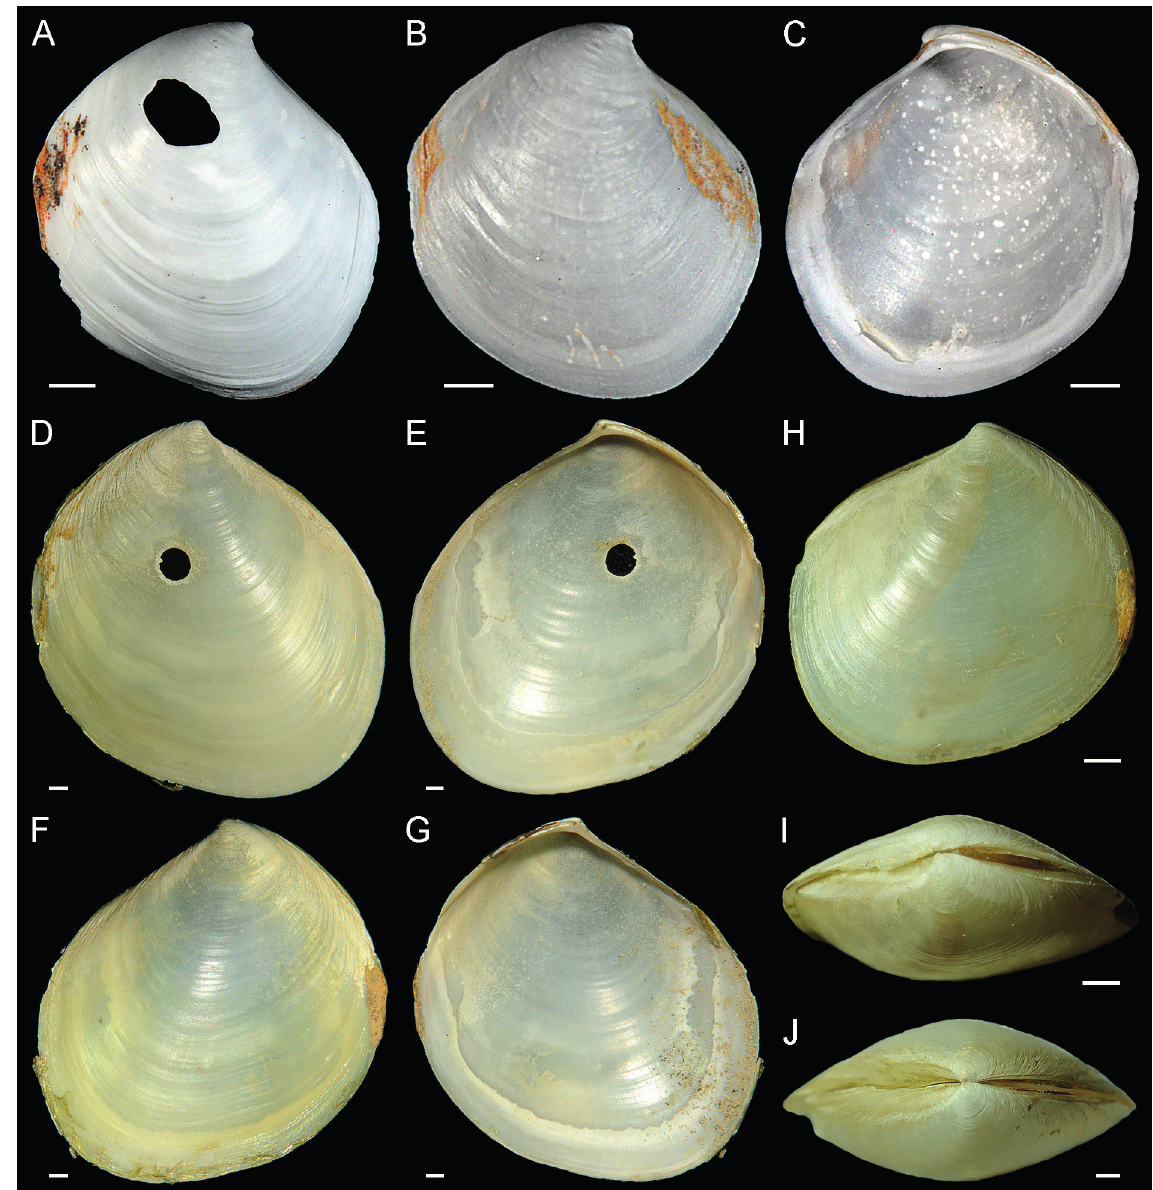
Fig. 7. A–C . Parathyasira biscayensis Payne & Allen, 1991. D–J . Axinulus obliquus Okutani, 1968. A . Holotype (MNHN-IM-38099), shell length 8.2 mm (photos by P. Maestrati (MNHN)). B–C . Paratype (MNHN-IM-38100), shell length 7.3 mm (photos by P. Maestrati (MNHN)). D–G . Holotype (NSMT Mo 69719), shell length 19.0 mm. H–I . Exterior and dorsal views of small specimen from the locality of the paratype (NSMT Mo 69720), shell length 10.0 mm (photos by Dr H. Saito (NSMT)). J . Dorsal view of paratype (NSMT Mo 69720), shell length 16.5 mm (photo by Dr H. Saito (NSMT)). Scale bars = 1